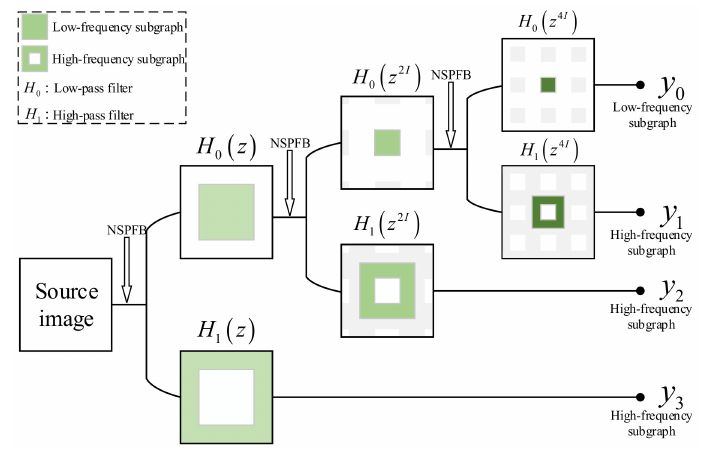
Figure 8. Three-level NSPFB pyramid filter bank.